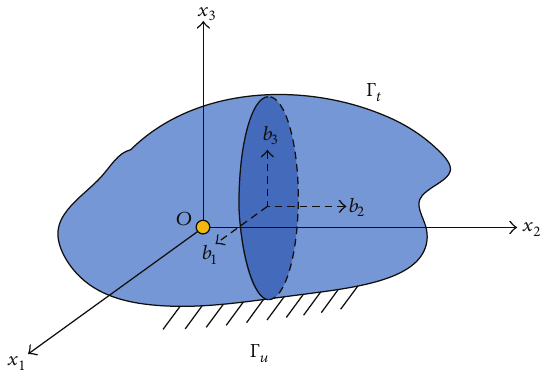
Figure 4: Geometrical definitions and boundary conditions for a general 3D